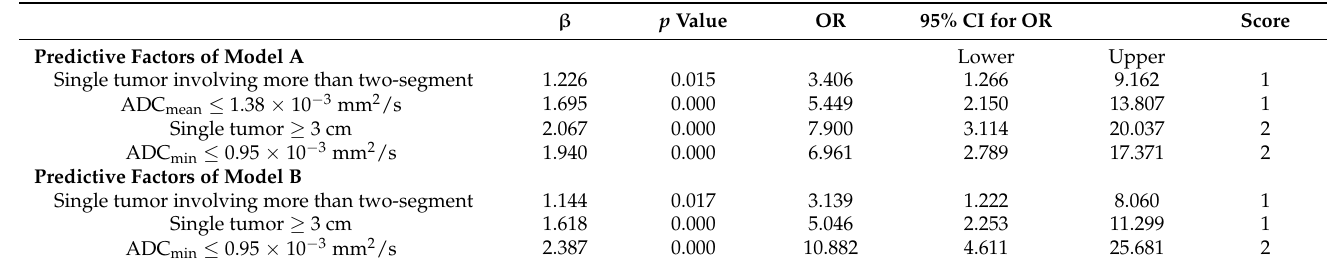
Table 3. Multivariate logistic regression analysis of two proposed scoring models. β p Value OR